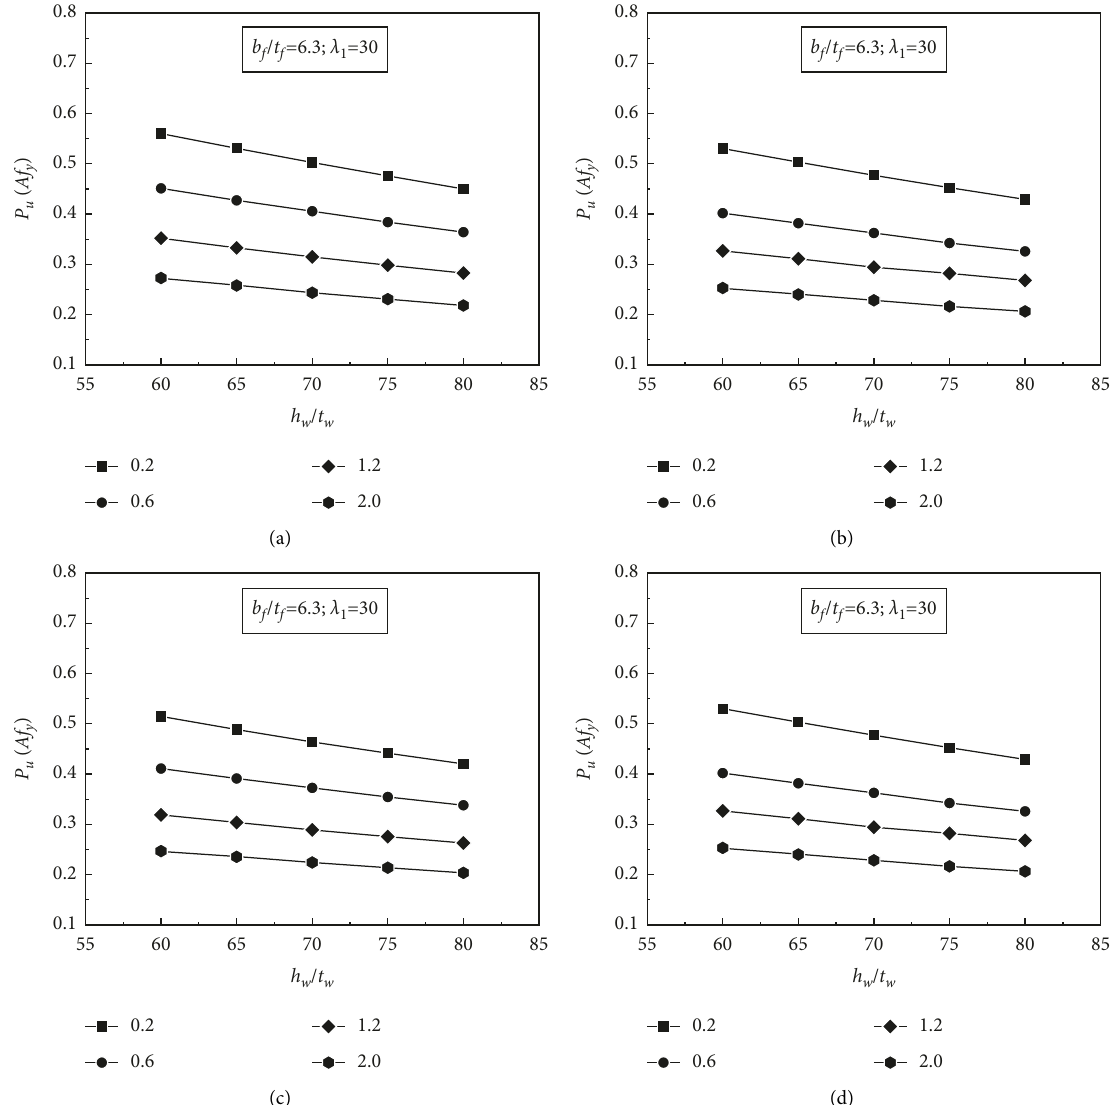
Figure 7: P u / Af y versus h w / t w under different &epsi; curves: (a) Q460; (b) Q690; (c) Q800; and (d)